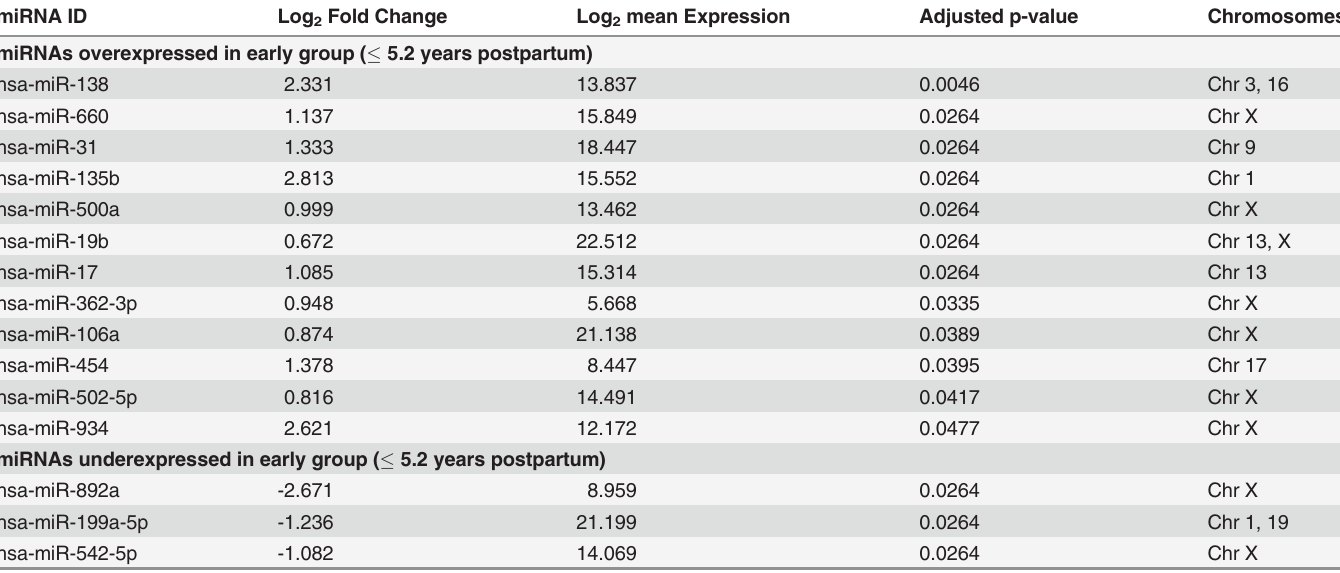
Table 1. MiRNAs differentially expressed between the early and late postpartum breast cancer